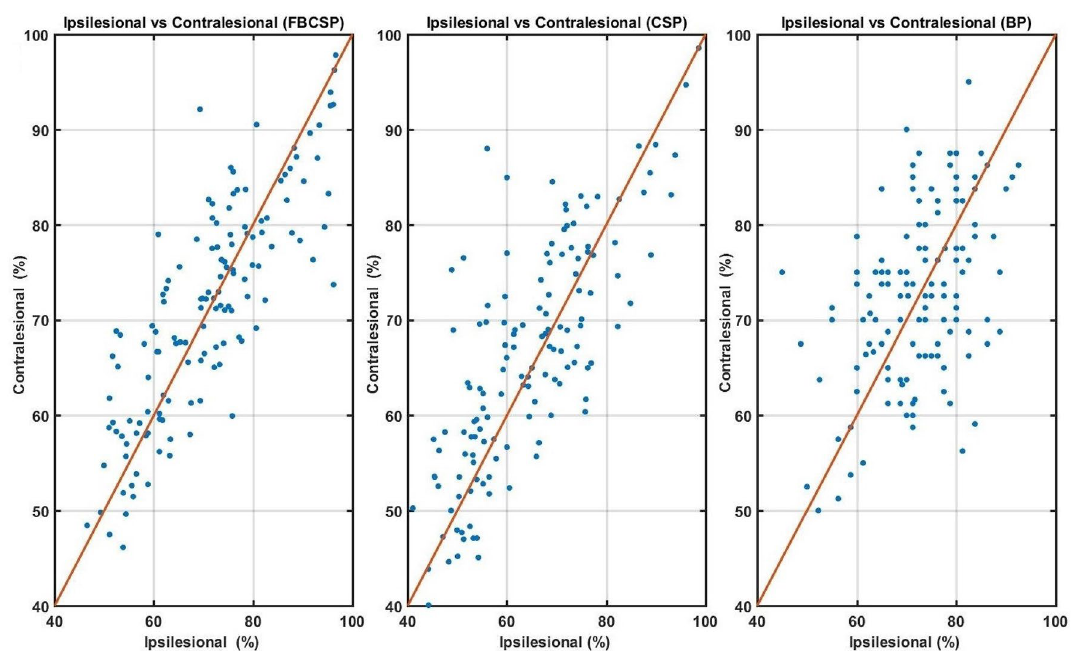
Figure 3. Scatter plots comparing the average cross validation accuracy of contralesional and ipsilesional BCIs using different feature extraction algorithms (FBCSP, CSP, and BP). The blue dots represent the average BCI accuracy for each stroke